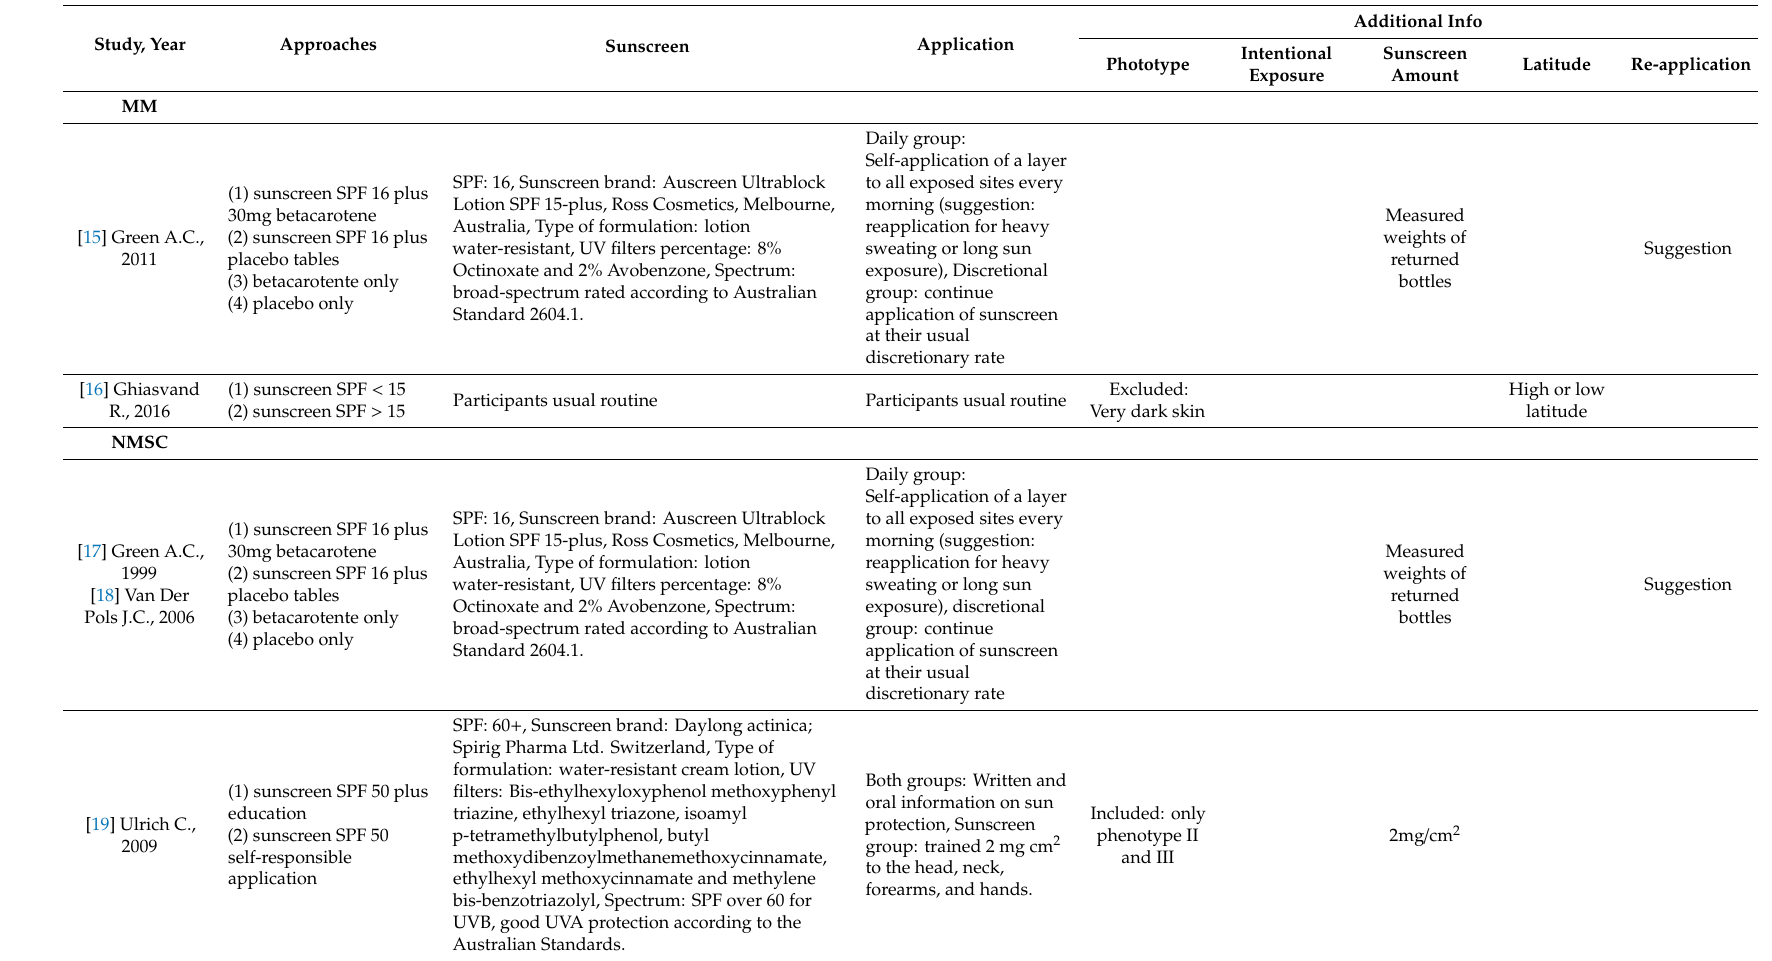
Table 2. Studies